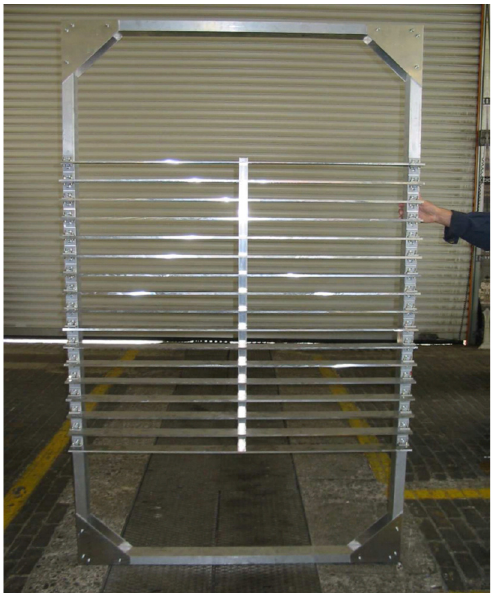
Figure 12. Example of a slat armour prototype (central stiffener removed before testing).